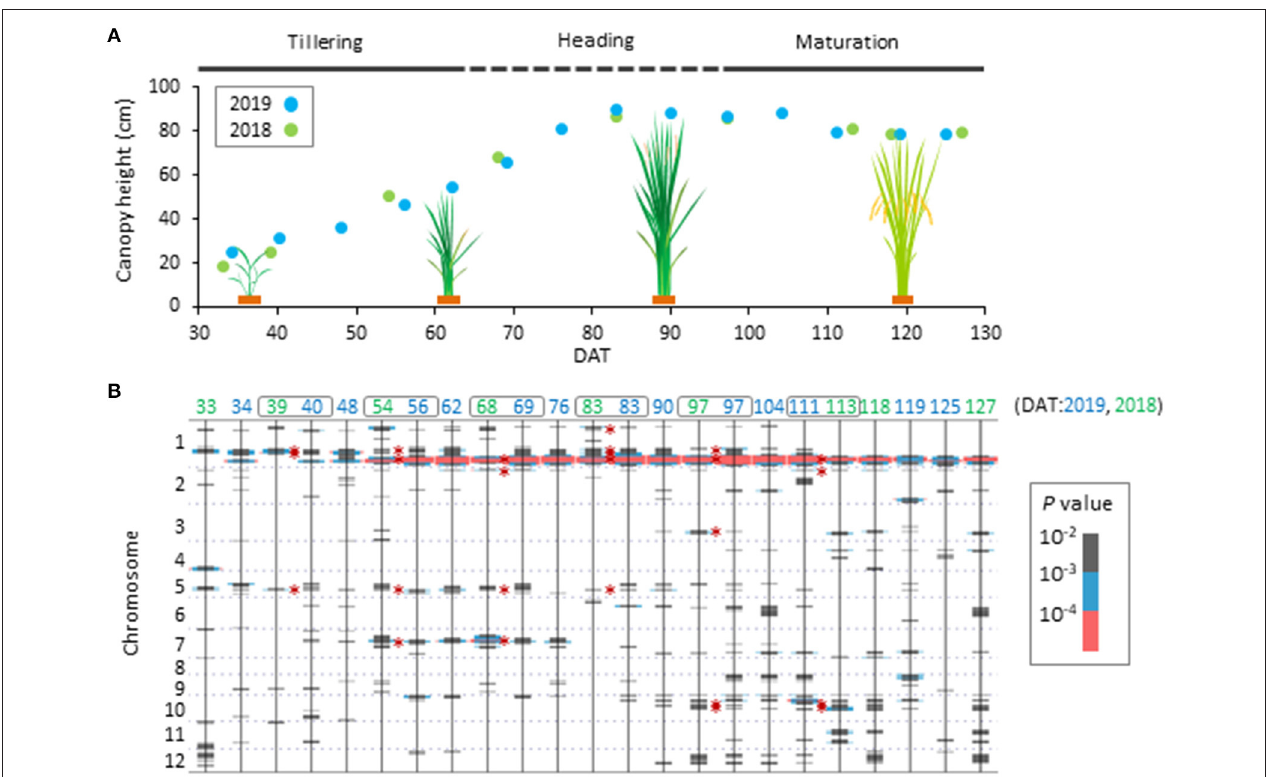
FIGURE 1 | Time-course pattern of QTL appearance in canopy height of JAM lines. (A) Scheme of phenological change of canopy height (CH) of the JAM lines. Average values of canopy height (CH) of the 165 JAM lines were plotted. There are tillering, heading and maturation stages in the developmental process. (B) Summary of haplotype-based genome wide association study on CH using the 165 JAM lines. Results from data collected in 2019 and 2018 are shown together arranged in ascending order of DAT from left to right. Bars in grey, blue and pink were added at positions where P -values are lower than 10 − 2 . Six time points of DAT indicated by grey boxes were focused on in this study. Defined QTL regions are marked with asterisks.